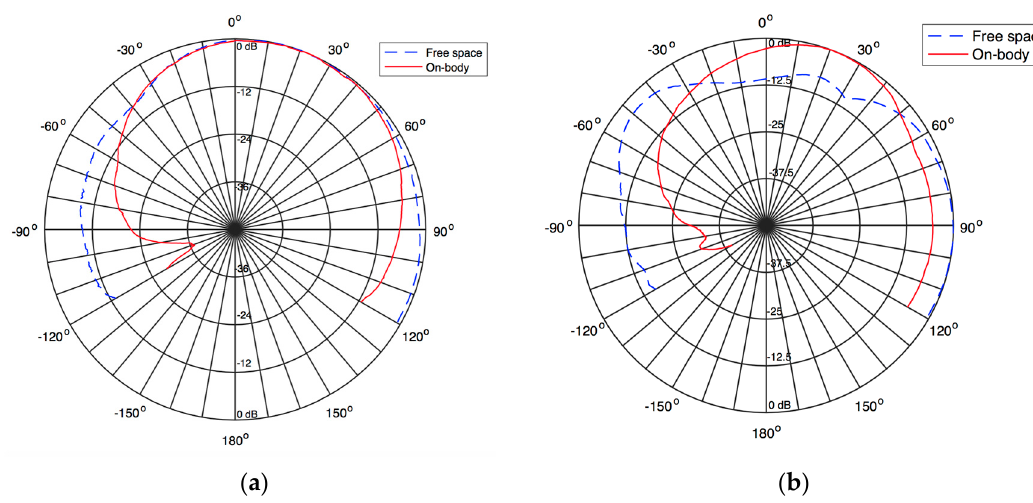
Figure 11. Measured radiation pattern of the textile antenna into the coat at ( a ) 900 MHz and ( b ) 1800 MHz.